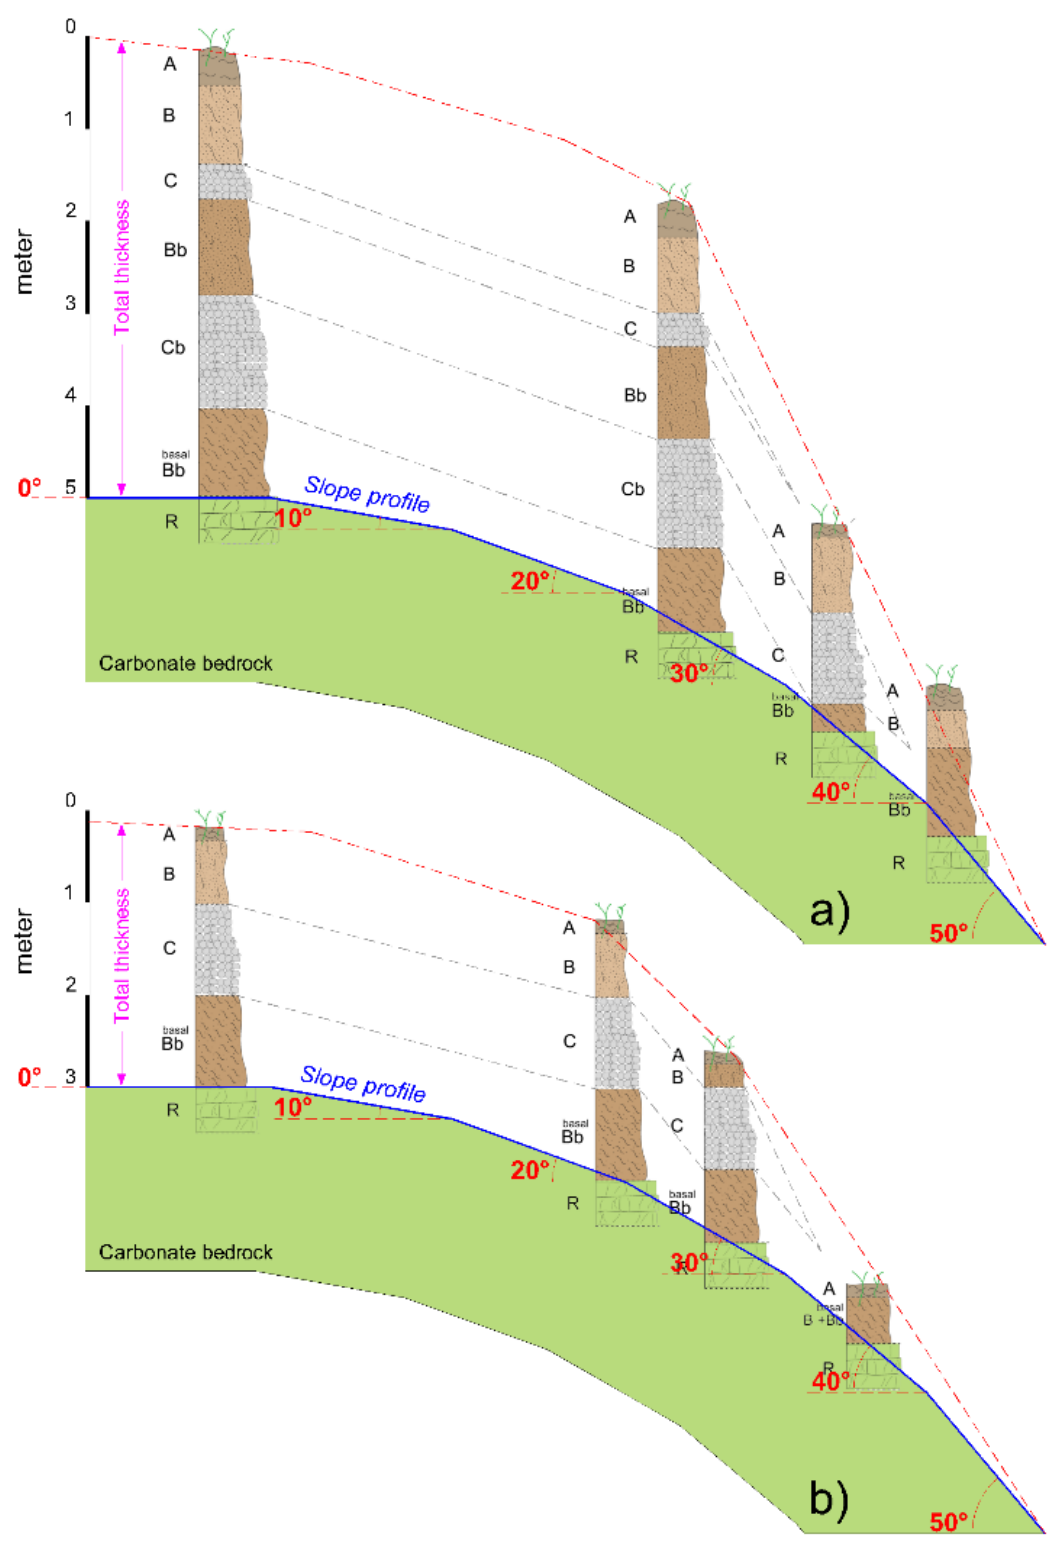
Figure 2. Empirical distribution model of pyroclastic fall soil thicknesses and stratigraphic settings depending on the slope angle for the Sarno ( a ) and Lattari ( b ) Mountains. In the slope angle range lower than 30°, the total thicknesses and stratigraphic settings well matched with those expected. Instead, for greater slope angle values, an abrupt decrease of total thicknesses and change of stratigraphic settings were observed up to the disappearance of the volcaniclastic soil cover for slope angle values greater than about 50°.